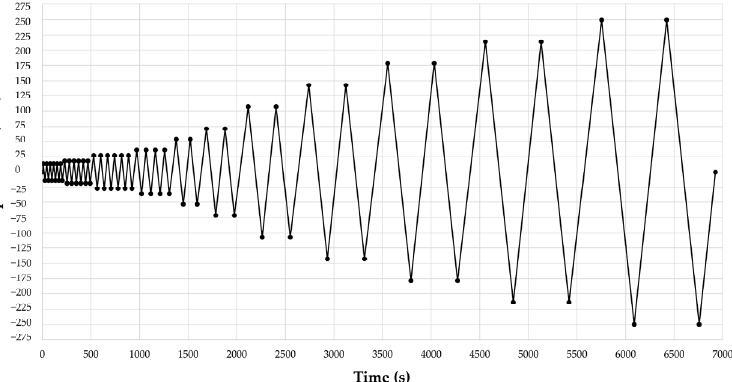
Figure 3. Displacement protocol. The abscissa is presented in units of time in s, obtained as the quotient between the displacement ∆ and the loading application speed v . In this case, v = 1.49 mm/s [19].